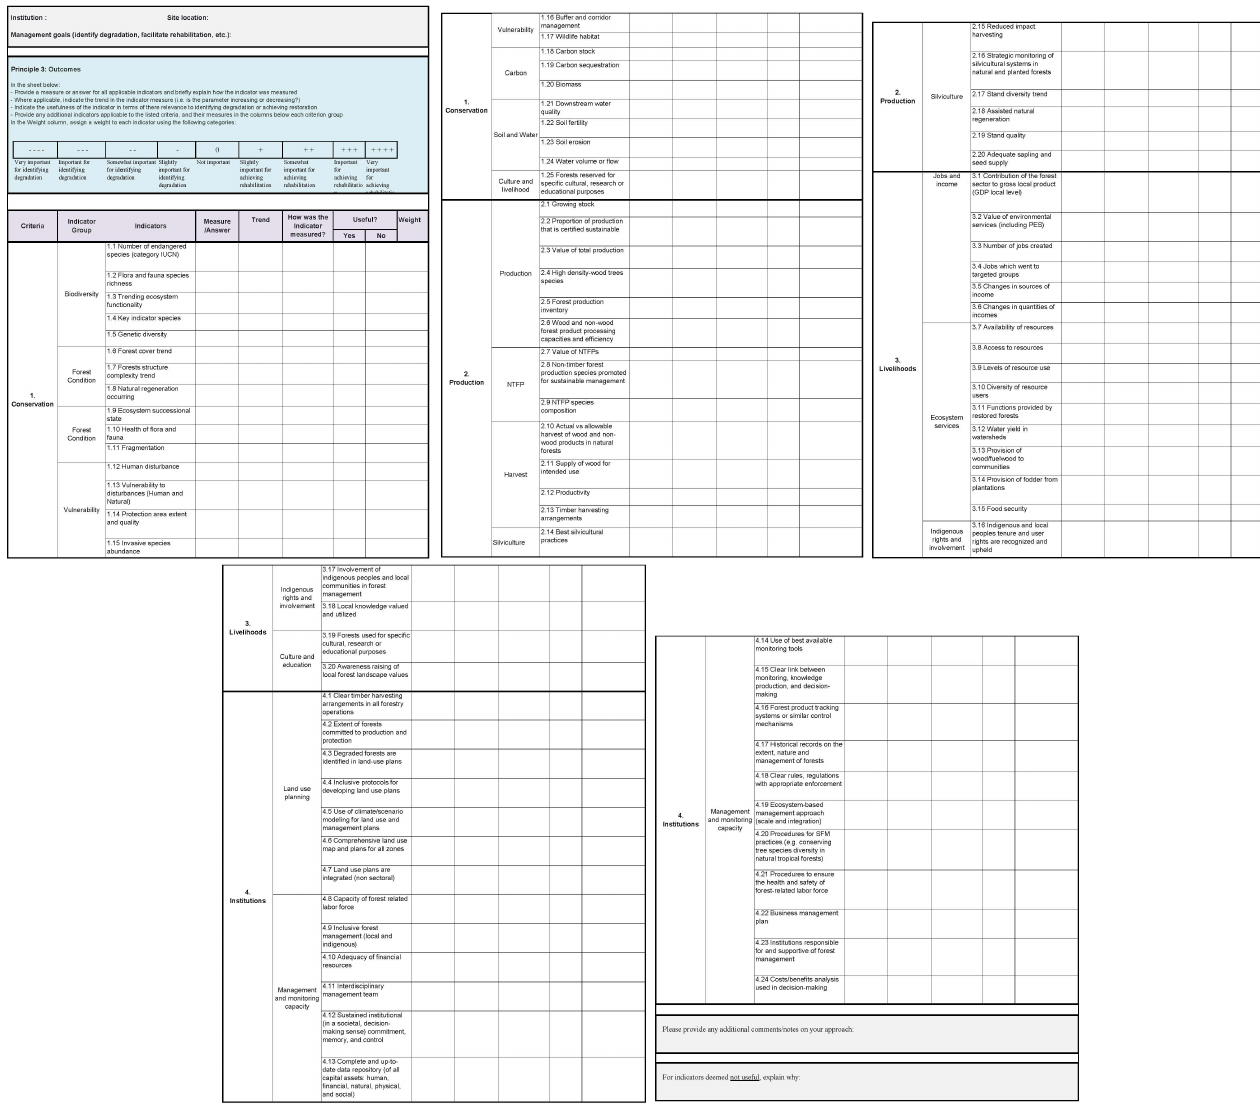
Figure A3. Outcomes Table.